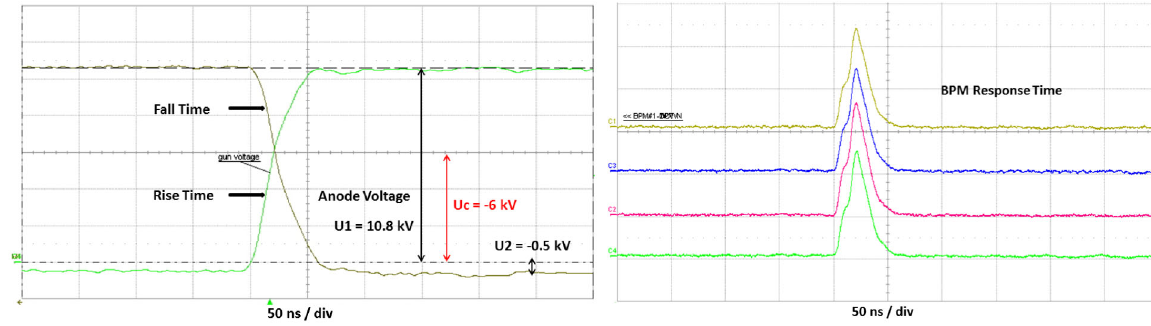
FIG. 13. Beam rise and fall time measurement via the anode voltage (left) and signals from the four BPM electrodes